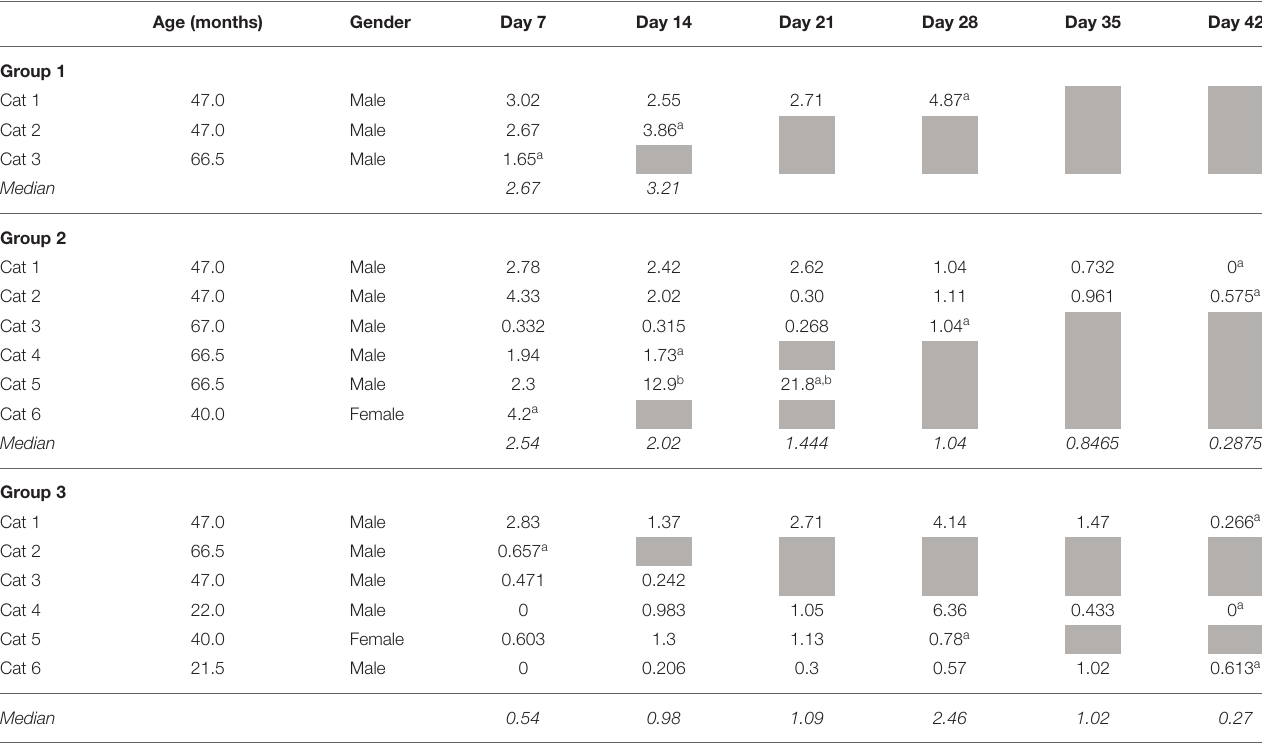
TABLE 1 | Exenatide plasma concentrations (ng/ml) in cats after subcutaneous implantation of OKV-119 in Group 1 ( n = 3, largest NanoPores with the fastest release), Group 2 ( n = 6, medium thickness ALD), and Group 3 ( n = 6, smallest NanoPores with a slower release). Age (months)